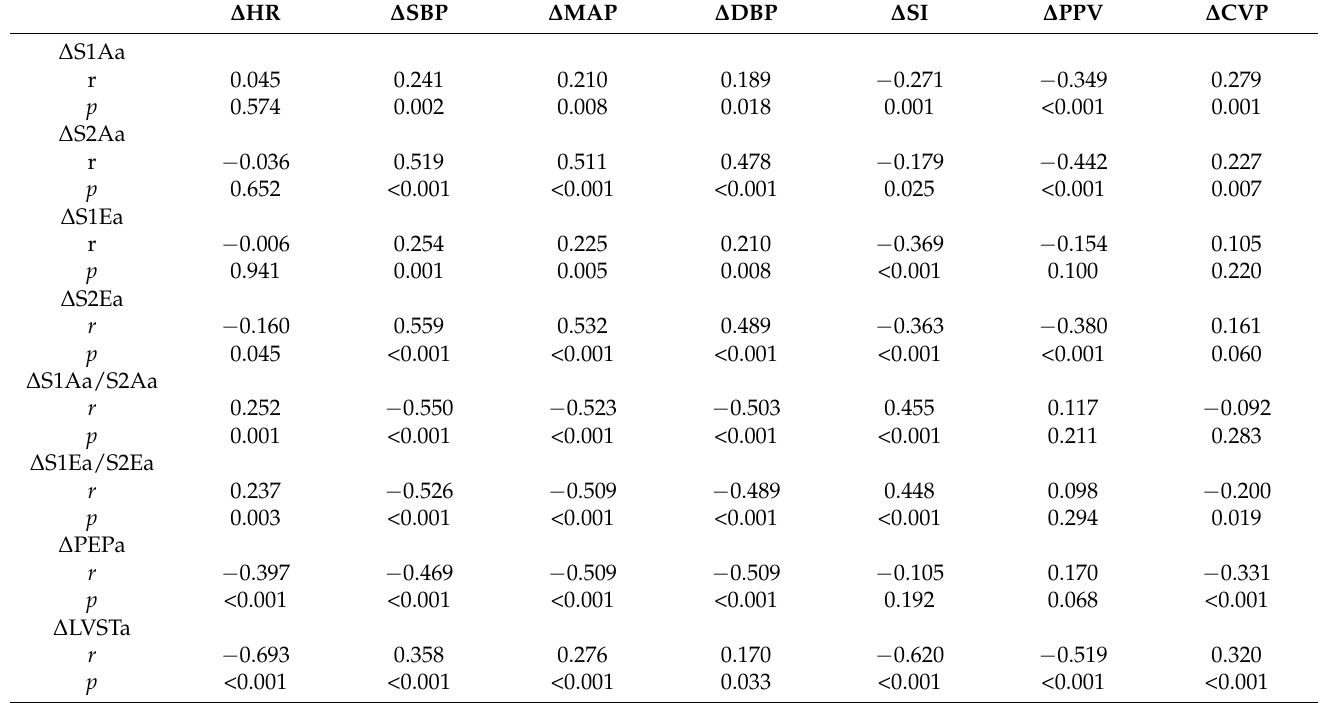
Table 1. Correlations between the heart sound parameters and circulatory